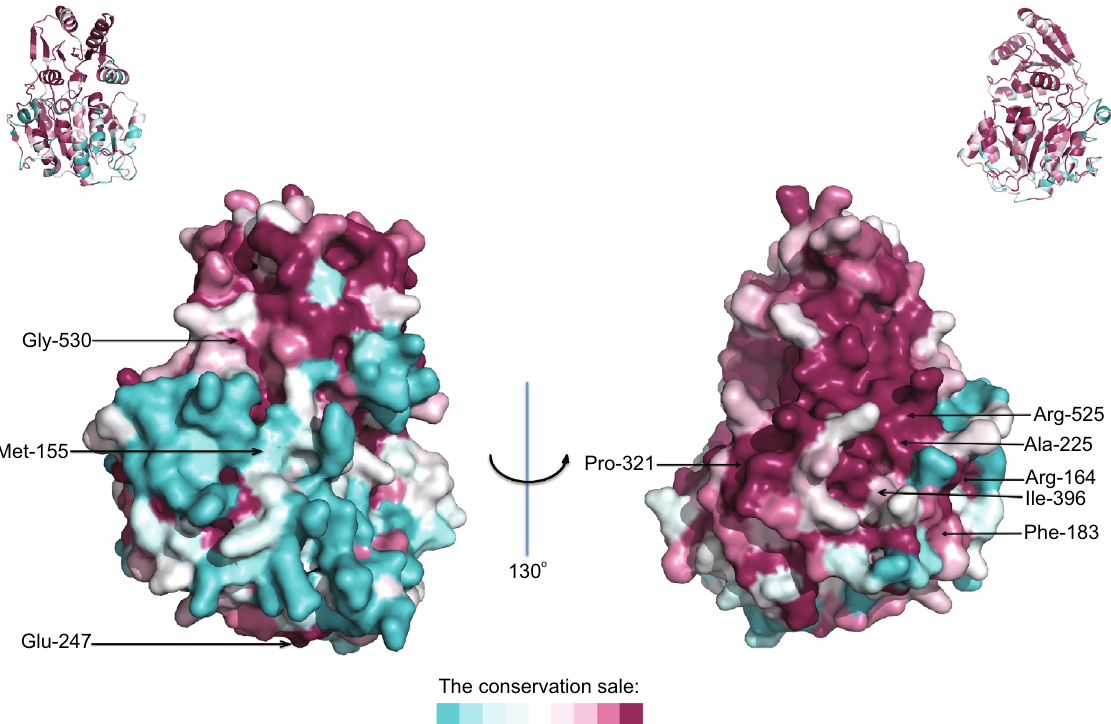
Figure 2. The amino acids conservation of human DDX41 DEAD and helicase domains. Graphical representation of the amino acids conservation using the predicted structure of human DDX41 is shown. Mutations related with MDS/AML are labeled. The color scale is based upon the level of conservation as determined by the ConSurf server. Category 9 corresponds to fully conserved residues. Small ribbon diagrams are shown at the